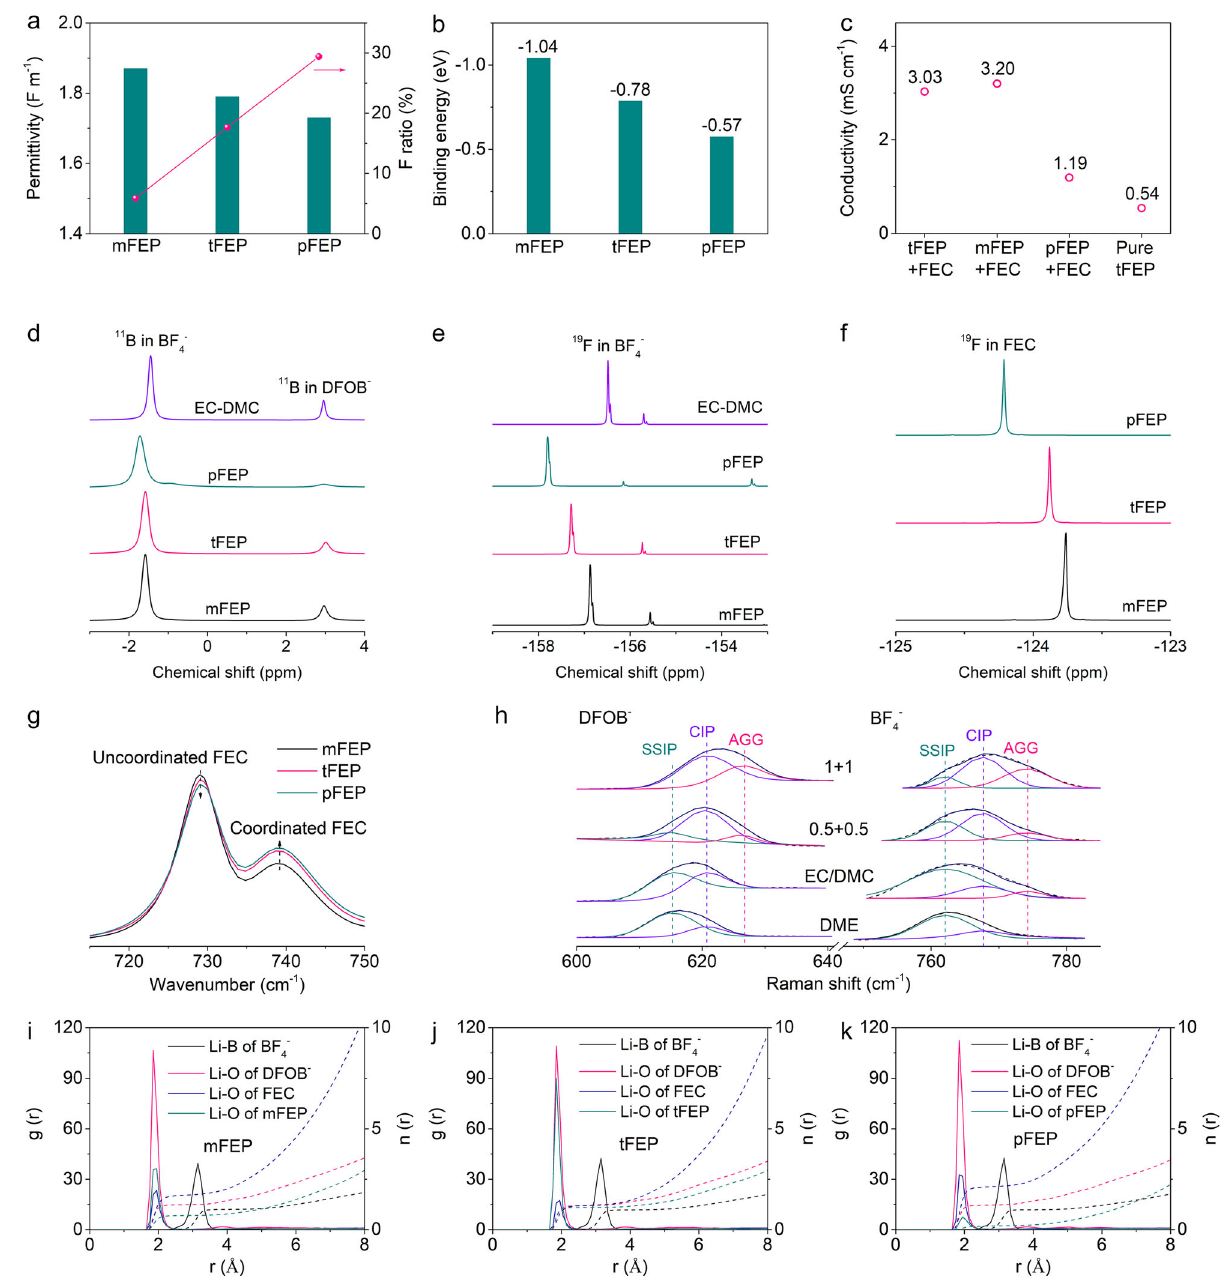
Fig. 2 | Evolution and simulation of the solvation structures. a Permittivity and fl uorine ratio of FEP-based solvents (mFEP, tFEP, and pFEP). b Molecular dynamic (MD) simulation results of the binding energy between a Li-ion and solvent in a carbonate oxygen site. c The conductivity of several electrolytes: 1M LiBF 4 +1M LiDFOB in tFEP/FEC, mFEP/FEC, pFEP/FEC, and pure tFEP electrolytes. d 11 B of BF 4 − andDFOB − , 19 Fof e BF 4 − and f FECNMRspectrain1MLiBF 4 +1MLiDFOBmFEP/FEC, tFEP/FEC, pFEP/FEC, and EC/DMC electrolyte. g FT-IR spectra of C=O